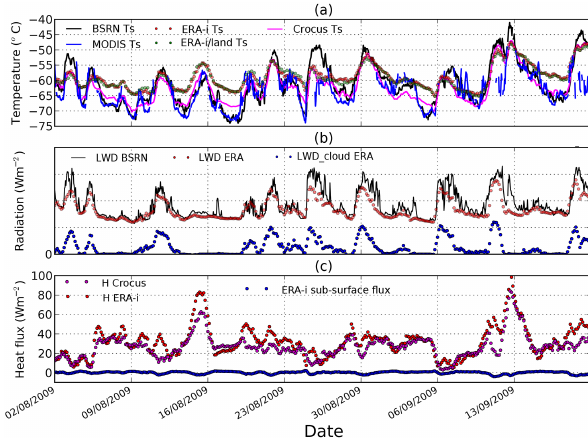
Figure 8. (a) Comparison between different observations of sur- face temperature at the South Pole: BSRN T s (solid black curve), Crocus T s (solid pink curve), ERA-i T s (red point), LST MODIS (solid blue curve) and ERA-i/land T s (green point). (b) Compari- son between thermal radiations: BSRN LW down (solid black curve), ERA-i LW down (red point) and ERA-i LW down_cloud (blue point). ERA-i LW down_cloud was obtained by the difference between ERA- i LW down and ERA-i clear-sky LW down . (c) Comparison between turbulent fluxes of sensible heat: Crocus H (violet point), ERA-i H (red point) and ERA-i sub-surface flux (blue